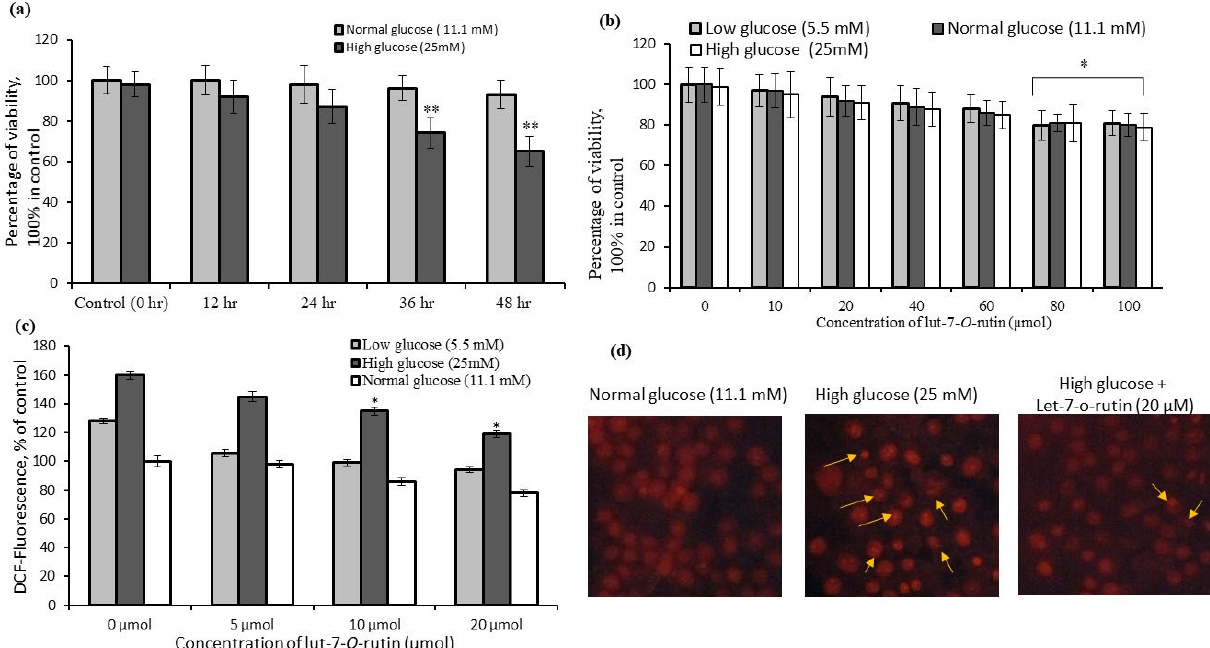
Figure 2. Comparative cell viability of RIN ‐ 5F cells cultured in normal ‐ and high ‐ glucose medium ( a ); the effect of increasing concentrations of lut ‐ 7 ‐ O ‐ rutinoside on cytotoxicity ( b ); High ‐ glucose ‐ induced intracellular ROS generation ( c ); propidium iodide staining assay to determine the protective effect of lut ‐ 7 ‐ O ‐ rutinoside on high ‐ glucose ‐ induced nuclear damage in RIN ‐ 5F cells ( d ). Each value is presented as mean ± SD for 6 replicates. In ( a ), **: p ≤ 0.001, lut ‐ 7 ‐ O ‐ rutinoside ‐ treated RIN ‐ 5F cells as compared between high ‐ glucose and normal ‐ glucose conditions. In ( b ), *: p ≤ 0.05, lut ‐ 7 ‐ O ‐ rutinoside ‐ treated RIN ‐ 5F cells as compared with untreated cells. In ( c ), *: p ≤ 0.05, lut ‐ 7 ‐ O ‐ ruti ‐ noside ‐ treated RIN ‐ 5F cells, as compared with low ‐ or high ‐ glucose concentrations.